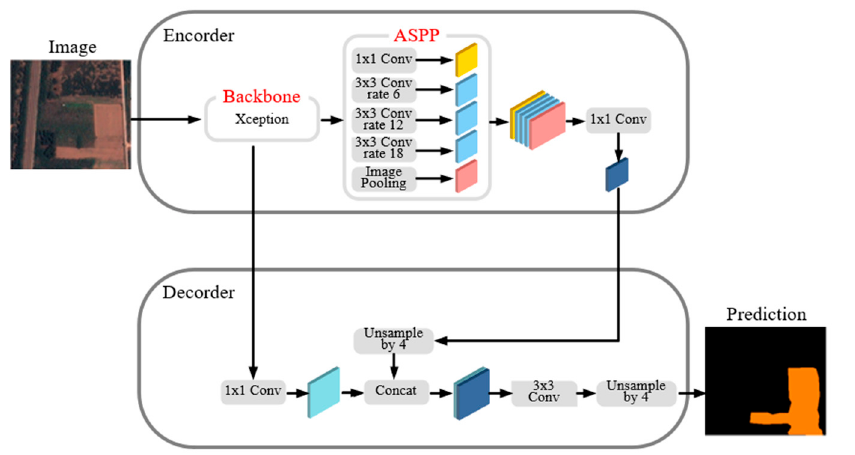
Figure 5. The framework of Deeplabv3+ model.